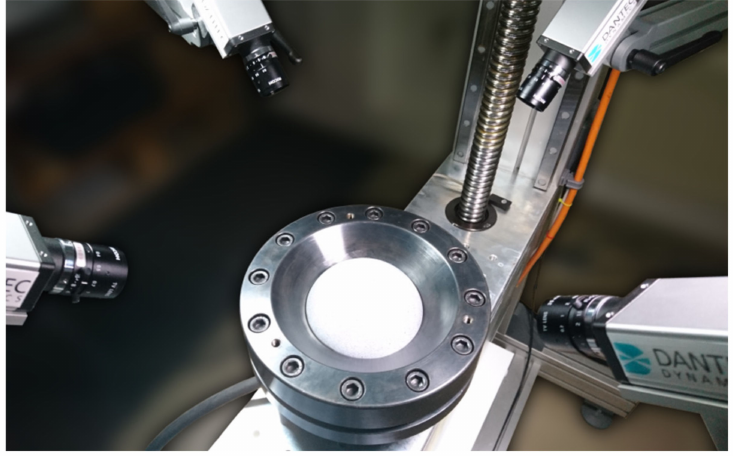
Figure 7. Bulge test setup with optical measurement equipment in the multi-cam configuration.